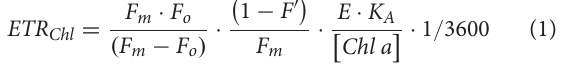
a fluorometer (Turner Designs, Model Trilogy, United States) routinely calibrated against spectrophotometric